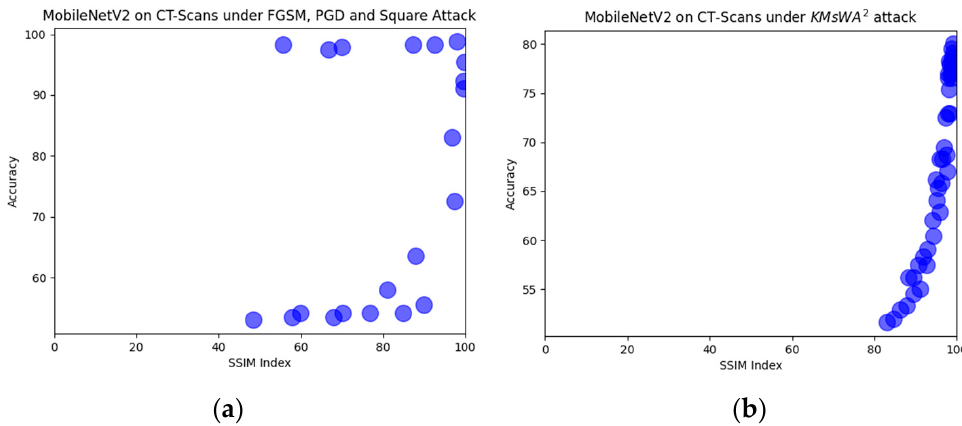
Figure 10. Scatter plots for MobileNetV2 in CT ‐ Scans under ( a ) FGSM, PGD, Square Attack, and ( b ) KMsWA 2 attack.